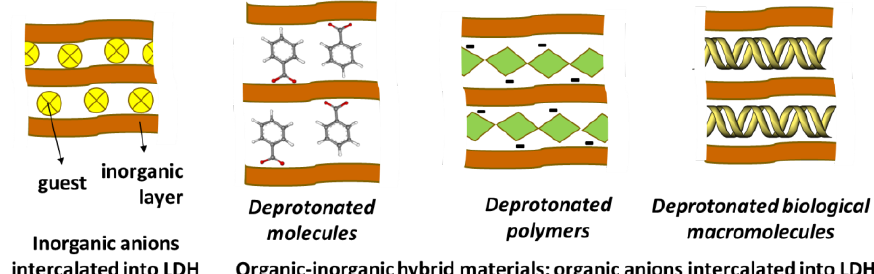
Figure 8. LDH materials can be intercalated with inorganic or organic anions to neutralize the layer’s charge.